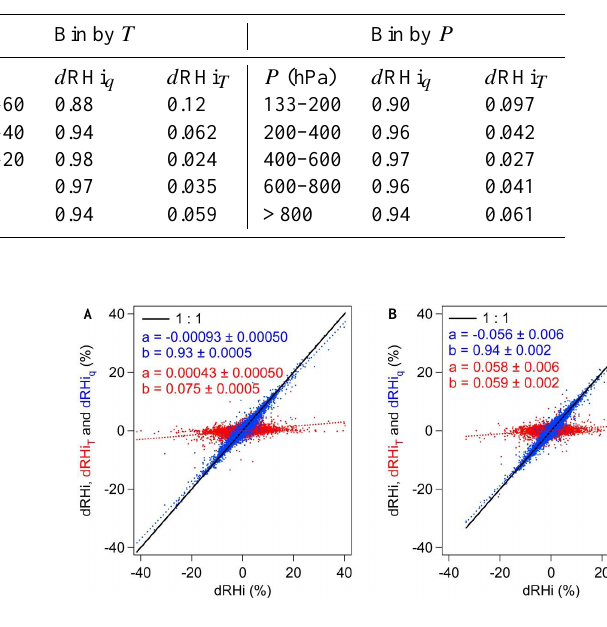
Table 2. Contributions of H 2 O and T horizontal variabilities to RH horizontal variabilities at various T , H 2 O and P ranges.